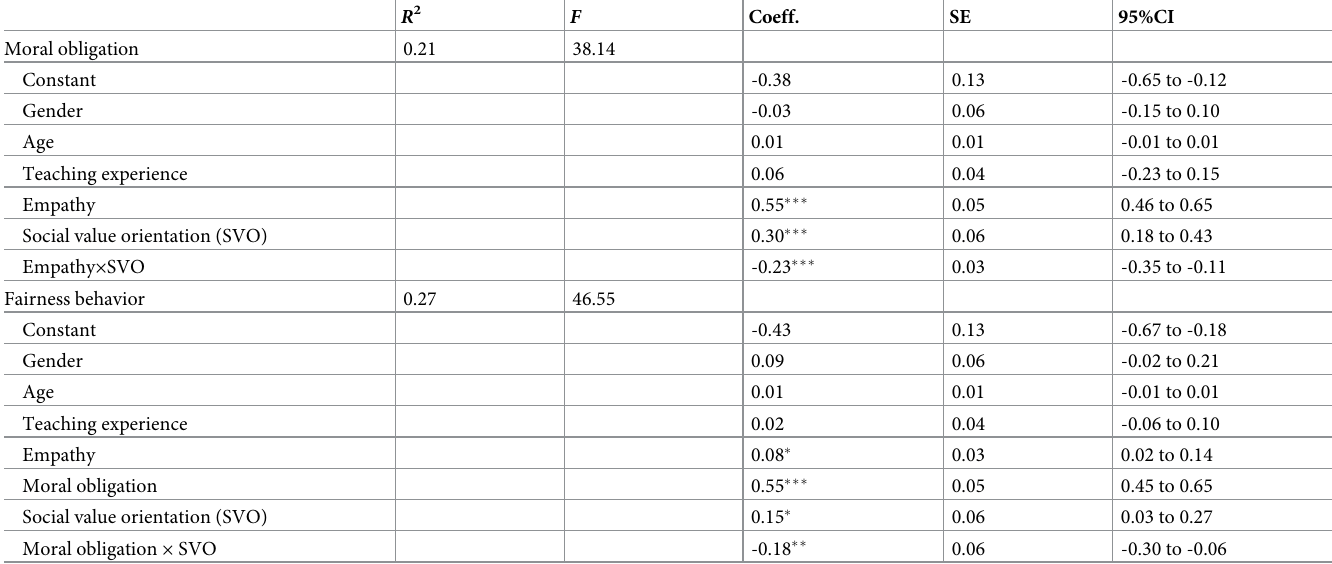
Table 2. Coefficients for the tested moderated mediation model ( N =